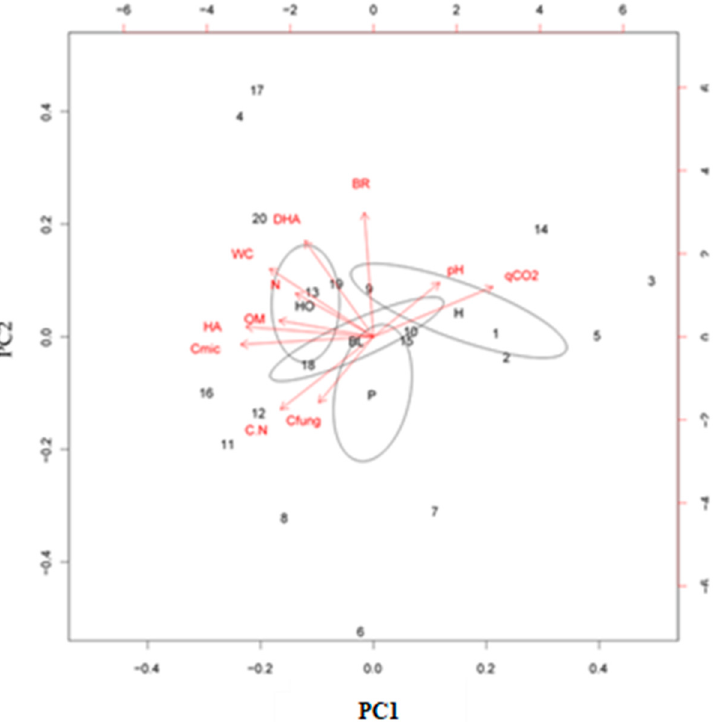
Figure 4. The principal component analyses (PCA) plots of abiotic (pH, WC, OM, N, and C/N) and biotic properties (BF, Cmic, BR, HA, and DHA), and their distribution in space for the soils collected after the fire (AF) under herbs (H), pine (P), black locust (BL), and holm oak (HO). Circle lines in the PCA plot are superimposed to show the sampling sites with the same vegetation type. H: soil sampled under herbs; P: soil sampled under pines species; BL: soil sampled under black locust species; and HO: soil sampled under holm oak species.